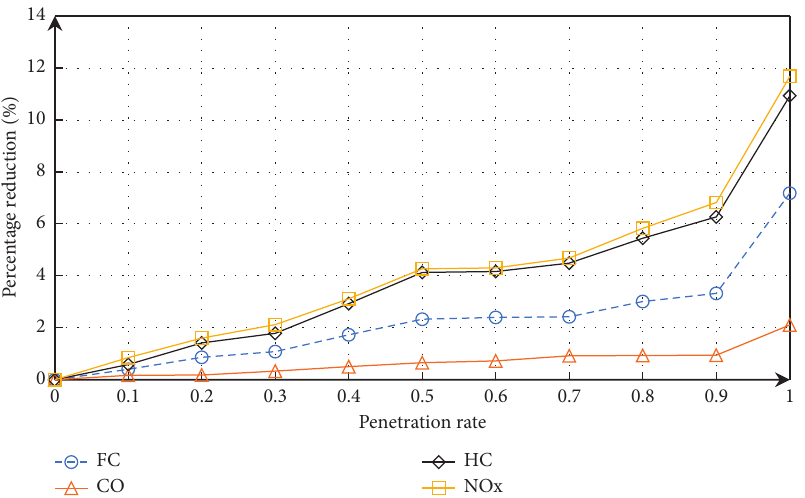
Figure 8: Percentage reduction in fuel consumption and traffic emissions (Scenario 2). Table 7: Fuel consumption and emissions under different penetration rates of CAVs (Scenario